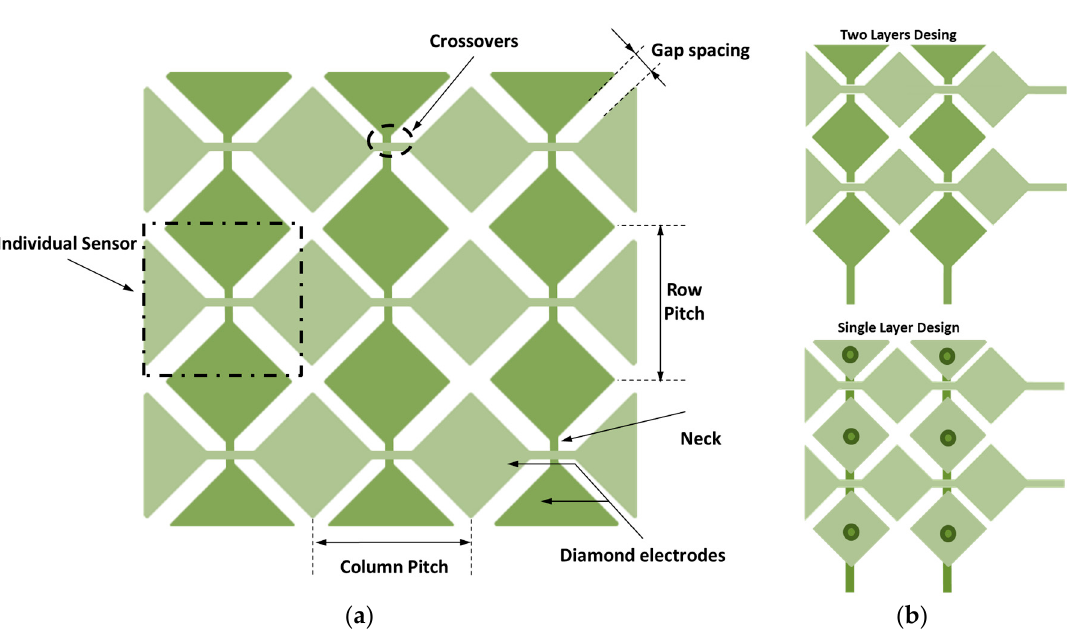
Figure 1. ( a ) Diamond pattern; and ( b ) 2D array sensors in the case of single layer or two